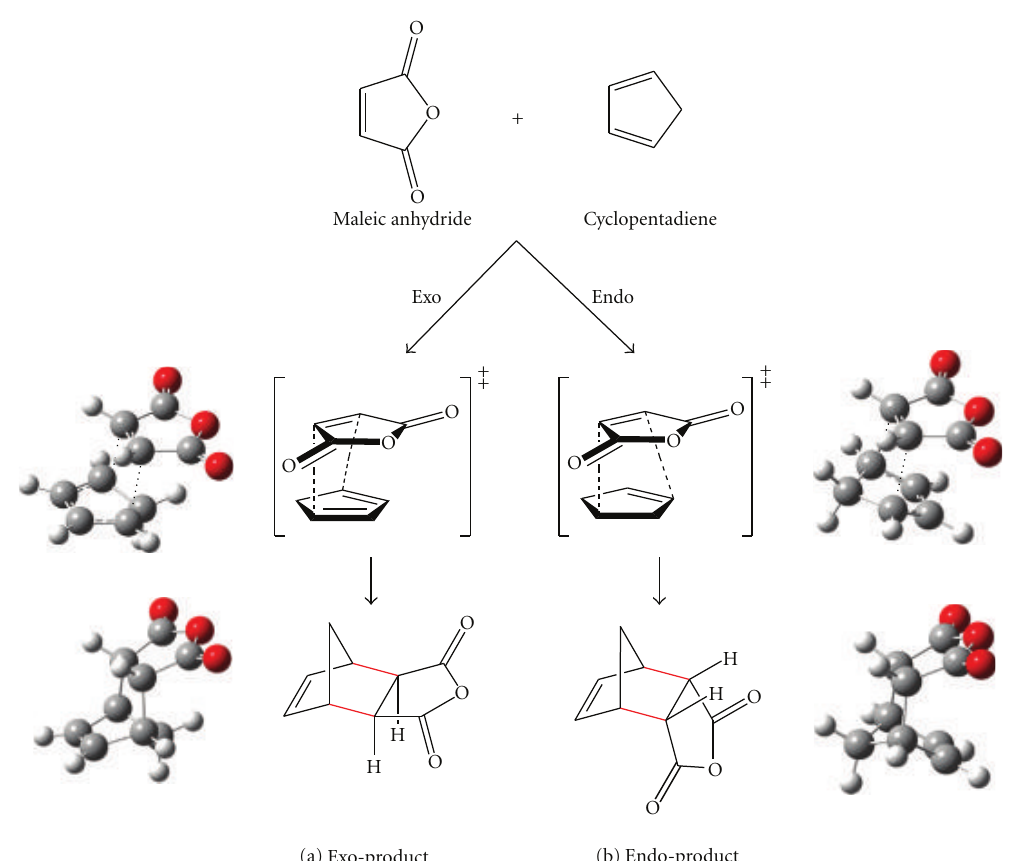
Figure 26: Diels-Alder cycloaddition between maleic anhydride and cyclopentadiene by (a) exo- and (b) endo-transition states [45].